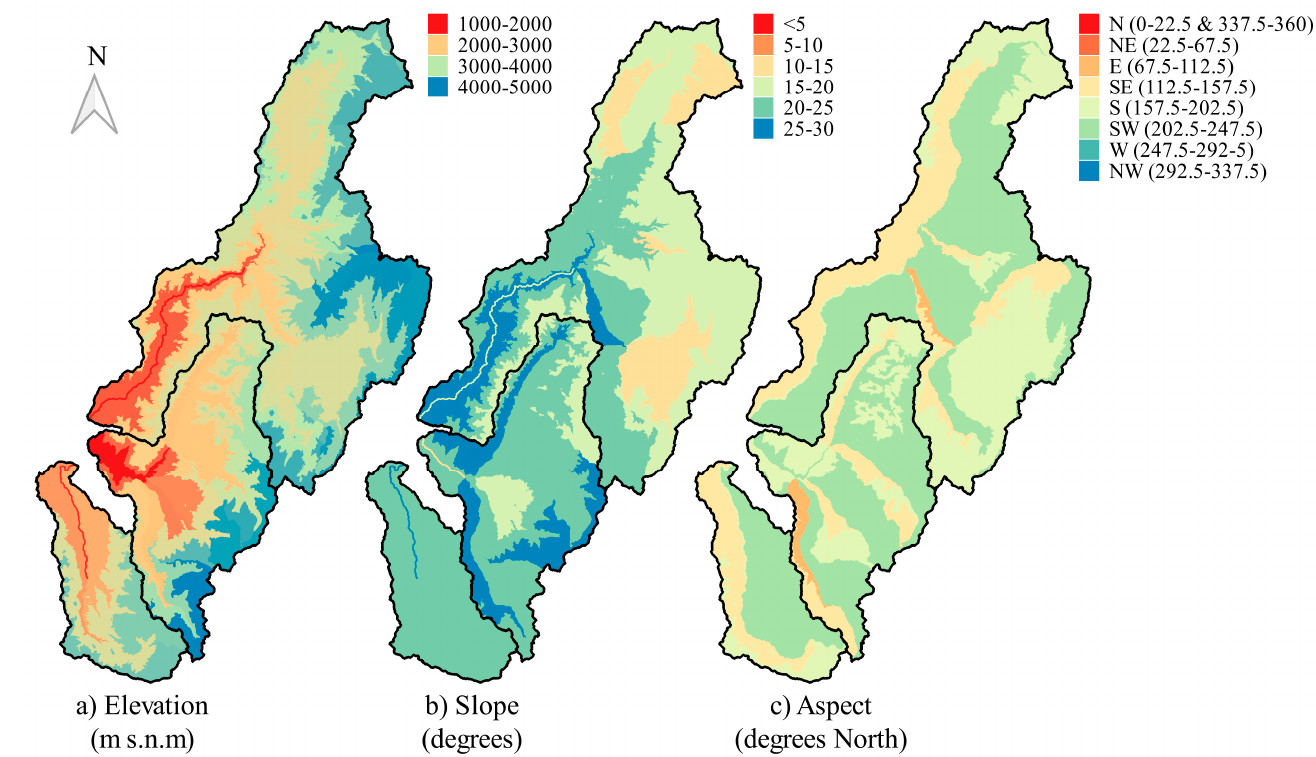
Figure 4. Main physiographic characteristics: elevation ( a ), slope ( b ) and aspect ( c ) derived from Shuttle Radar Topography Mission’s digital elevation model, spatially averaged for each hydrological response unit (HRU) at